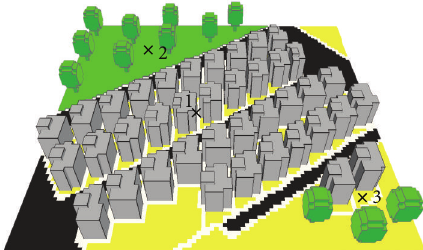
Figure 14: The location of three different points in the study area.